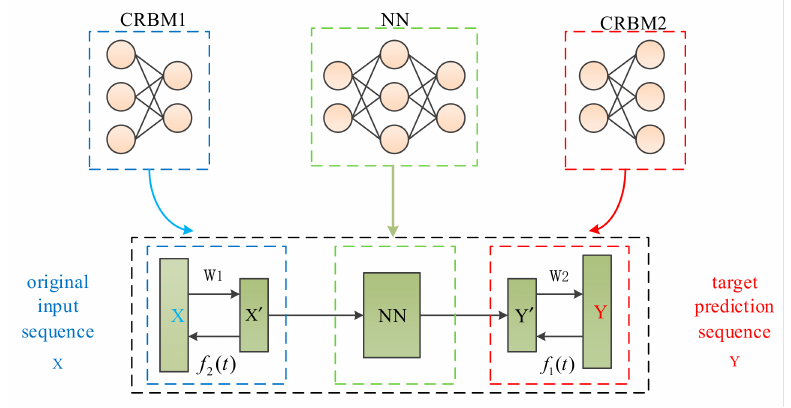
Figure 2. CRBM-NN flow